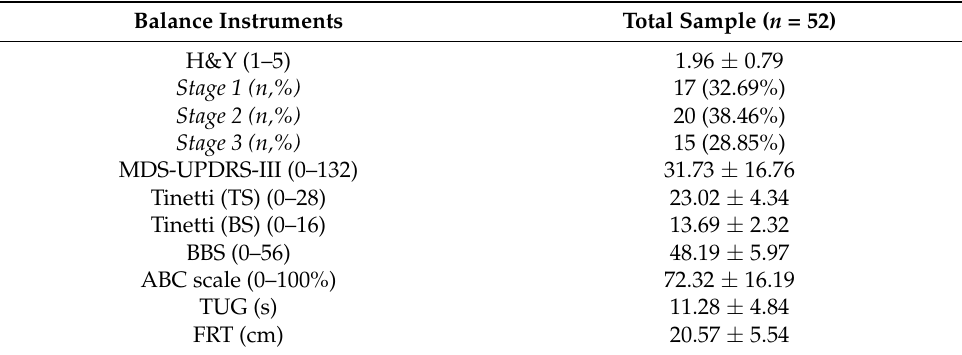
Table 2. Clinical balance assessment